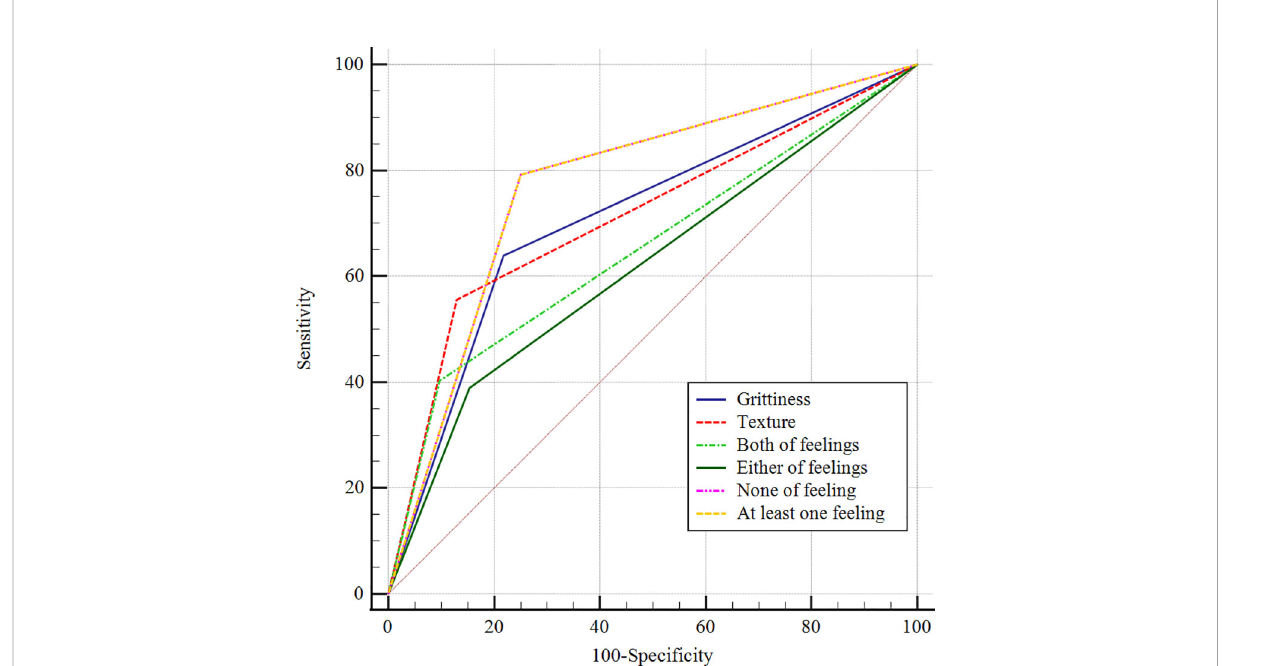
FIGURE 1 ROC curves for puncture feeling in the differential diagnosis of benign and malignant thyroid nodules with indeterminate FNA fi ndings.